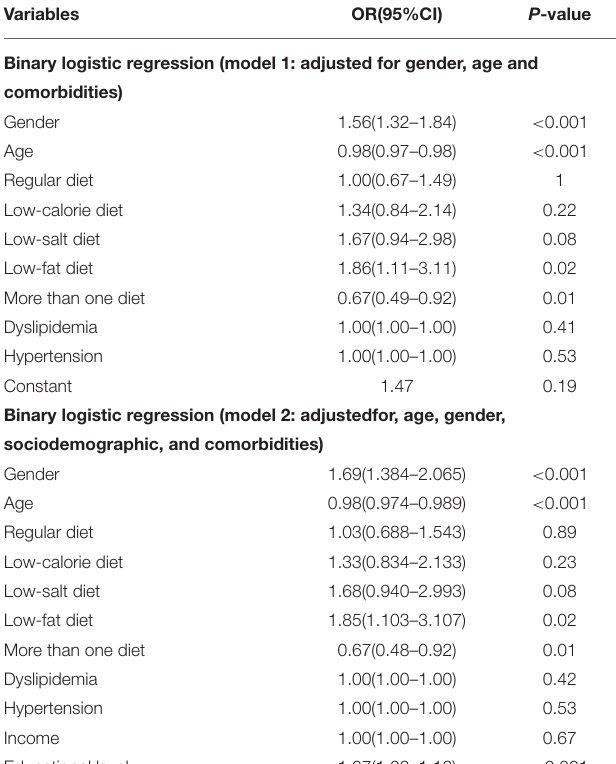
TABLE 3 | Association between types of diets and other variables with glycemic control based on HbA1c. Variables Binary logistic regression (model 1: adjusted for gender, age